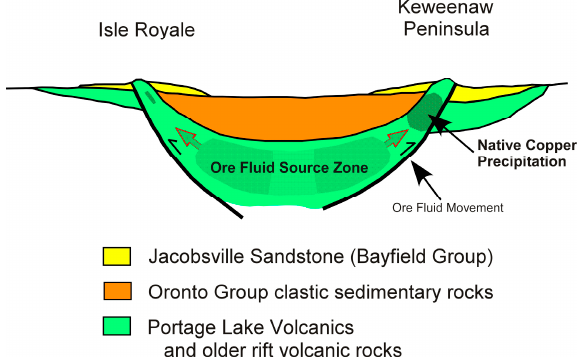
Figure 3. Cartoon geologic cross section showing the conceptual model for the native copper deposits of the Keweenaw Peninsula. Section from Isle Royale to the Keweenaw Peninsula, which can be seen in Figure 1. Metamorphogenic ore-forming fluids are derived from a source zone at depth below the native copper deposits in the same basalt-dominated stratigraphic section that hosts the deposits. Ore-forming fluids move upward and precipitate native copper at depths below the surface corresponding to zeolite to prehnite-pumpellyite facies low temperature and pressure conditions.